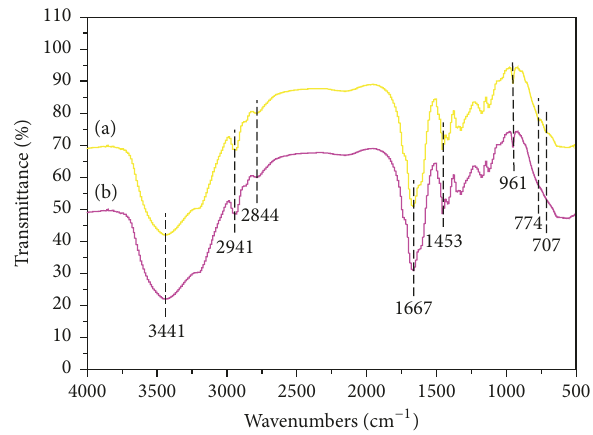
Figure 3: FT-IR spectra of (a) PADA and (b) PAD.